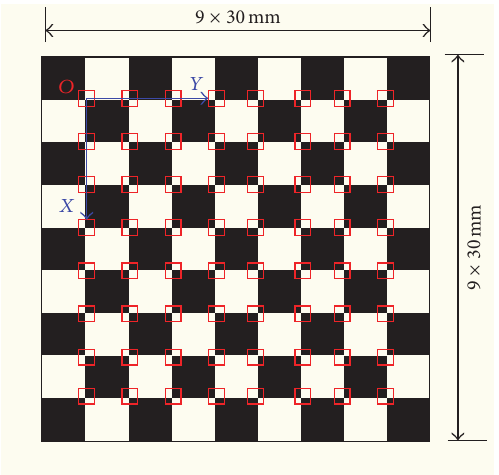
Figure 4: Planar